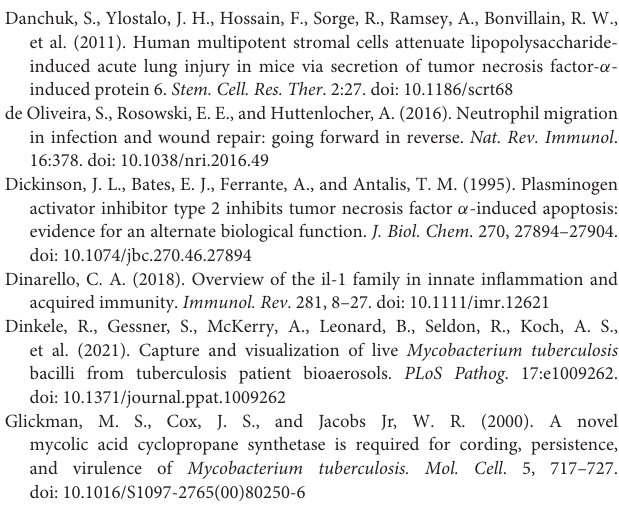
Supplementary Figure 1 | Quantification of the number of Mtb bacilli per macrophage in flow cytometry data. (A) A distribution of bacterial fluorescence, within infected macrophages, was obtained using confocal fluorescence microscopy prior to flow cytometric sorting of macrophages. Single Mtb bacteria were identified in the image and their position within the fluorescence distribution was determined. (B) This position was then applied to the matching distribution from cell sorting data to quantify bacteria. Scale bar = 20 µ m. Supplementary Figure 2 | Transcriptional upregulation and secretion of TNF α and downstream genes with aggregated versus single Mtb infection. (A) Normalized transcripts or (B) cytokine secretion 3 h post-Mtb infection. MDM were either uninfected (UI), infected with single Mtb culture (SCI) or with aggregated Mtb culture (ACI). Shown are median and IQR of the transcriptional or cytokine response from 15 independent infections of MDM from 5 blood donors. p-values are ∗ < 0.01; ∗∗ < 0.001; ∗∗∗ < 0.0001; ∗∗∗∗ < 0.00001 as determined by Kruskal-Wallis test with Bonferroni multiple comparison correction. Supplementary Figure 3 | Schematic overview of semi-automated histological image analysis. (A) The section was scanned using a Hamamatsu Nanozoomer 2.0 rs slide scanner and exported to (B) ImageJ to split large files into smaller image tiles in preparation for processing in Matlab. (C) Smaller image tiles were individually loaded into Matlab and (D) thresholded in the Mtb channel to create binary masks corresponding to the locations of Mtb bacilli. Each of these individual binary object masks (E) were applied to the original RGB image (F) to isolate full RGB profiles of the objects. Each of these object profiles was then compared to a reference RGB pattern that matched the RGB profile of stained Mtb (G) . Objects that were within the RGB thresholds were added to the database. Objects that succeeded the RGB profile thresholds were then individually manually curated (H) and added to the curated database (I) . Supplementary Movie 1 | Infection of macrophage with live Mtb aggregates. Monocyte derived macrophages were infected with live Mtb aggregates (red) and incubated with the cell membrane permeability dye DRAQ7 (green). Penetration of DRAQ7 indicates loss of membrane integrity and cell death. Scale bar = 20 µ m, time is hh:mm. Supplementary Movie 2 | Infection of macrophage with heat-killed Mtb aggregates. Monocyte derived macrophages were infected with heat-killed Mtb aggregates (red) and incubated with the cell membrane permeability dye DRAQ7 (green). Absence of DRAQ7 signal indicates retention of cell wall integrity indicative of a viable cell. Scale bar = 20 µ m, time is